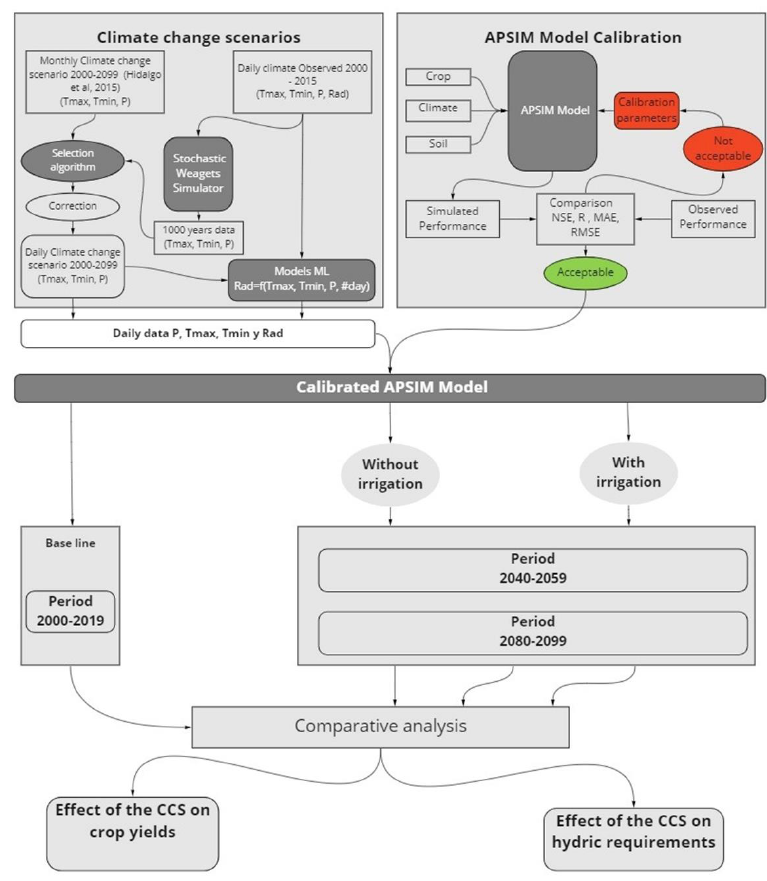
Figure 3. Methodological diagram of the data analysis.